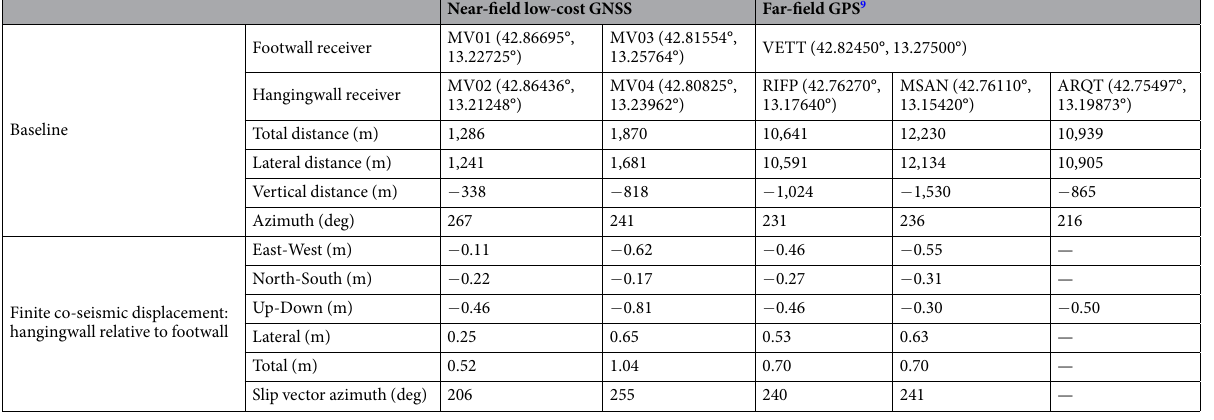
Table 1. Baseline parameters and finite co-seismic displacements for near-field GNSS and far-field